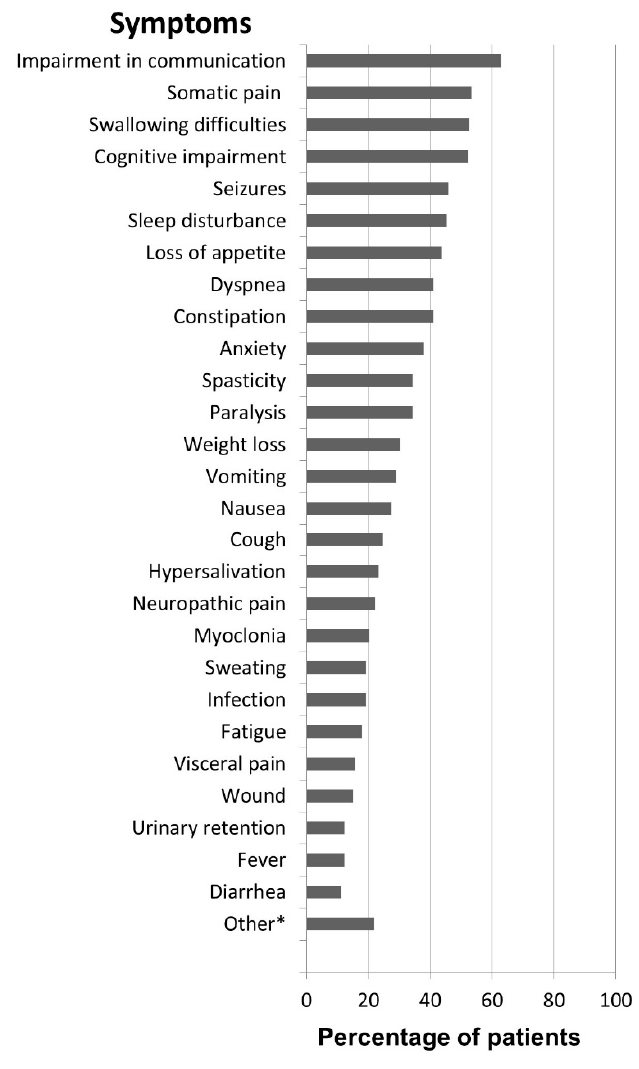
Figure 1. Symptom prevalence. * Other: hypothermia, dry mouth, edema, itching.